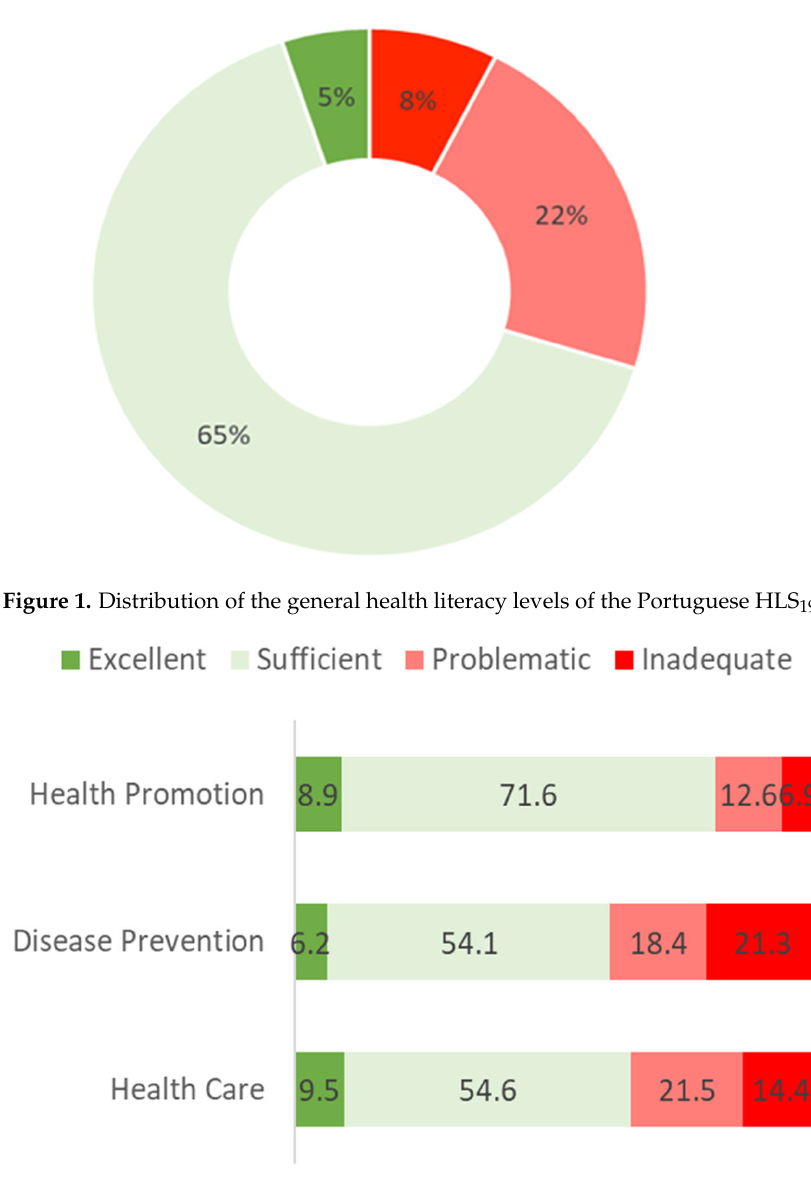
Figure 1. Distribution of the general health literacy levels of the Portuguese HLS 19 sample.